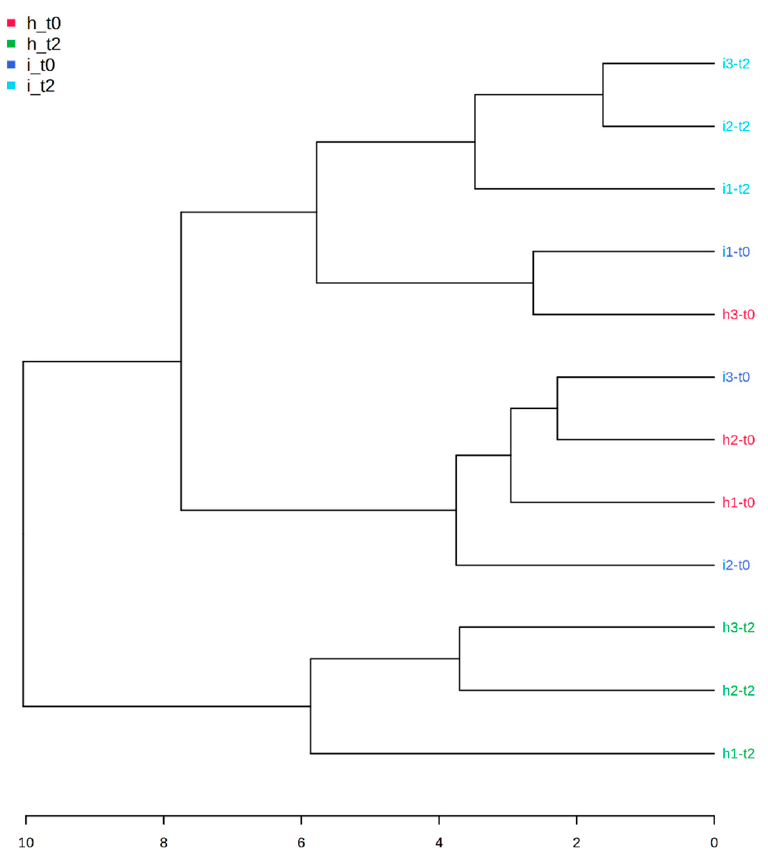
Figure 3. Dendrogram of samples based on HCA performed on the VOCs identified in healthy (h) and OYDV-infected (i) samples for t 0 and t 2 sampling times.